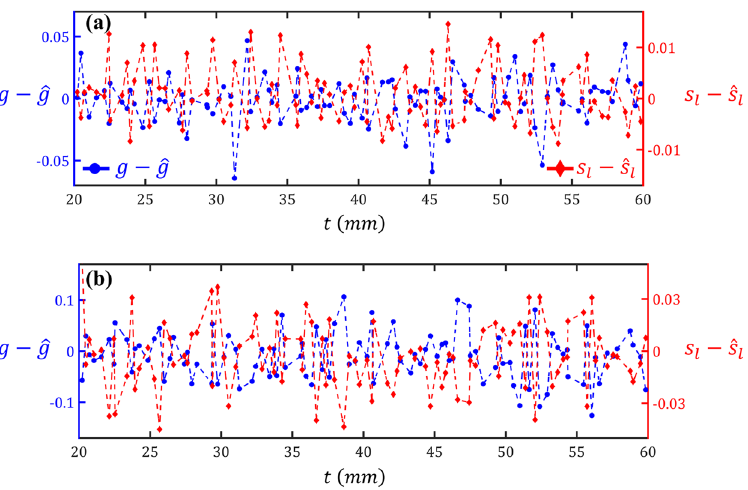
Figure 8. Errors in predicting the scattering properties of 100 tissue samples while enforcing 10% error in thickness value: In ( a ) and ( b ) the thickness value used in the inverse optimization is, respectively, increased and decreased by 10% from the original value used in Zemax simulations. The simulations are ordered with respect to the sample